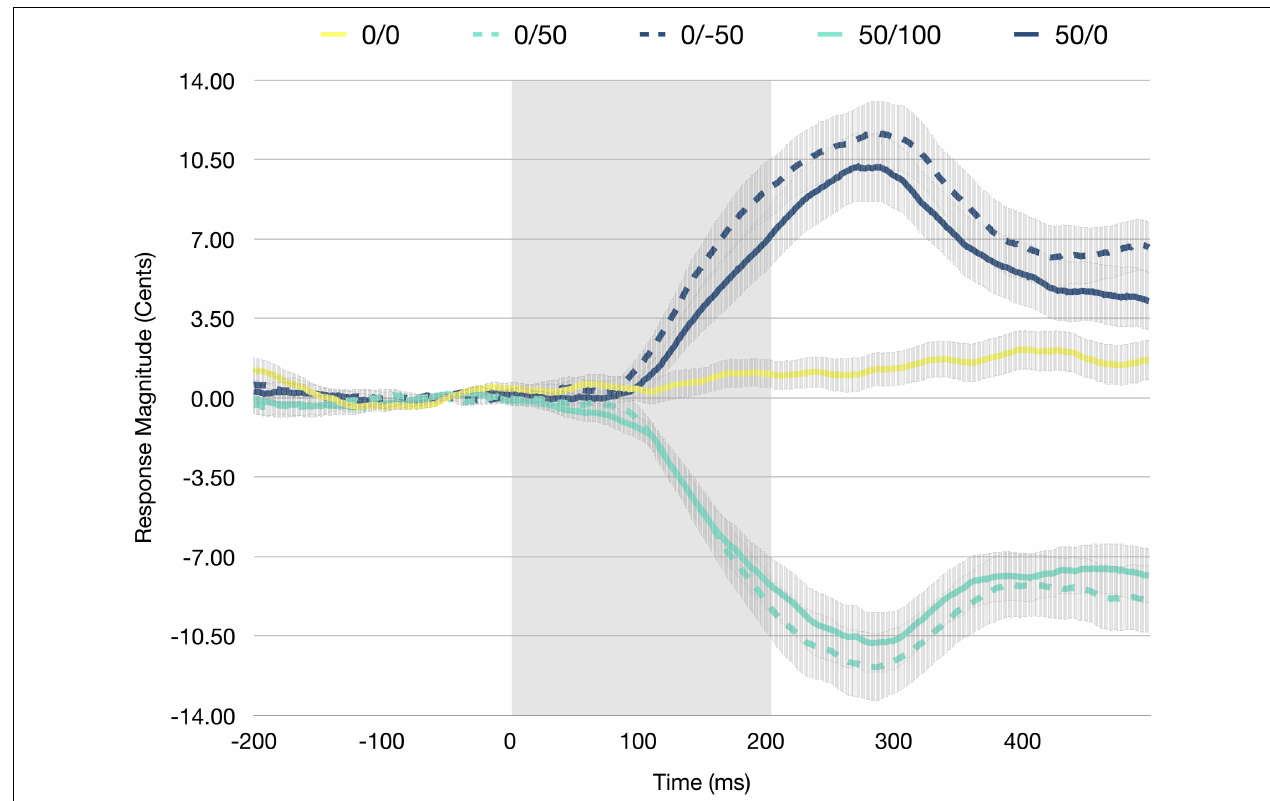
FIGURE 2 | Averaged F0 trace averaged across all participants for the unaltered (0/0), control up (0/50), control down (0/ − 50), experimental up (50/100), and experimental down (50/0) conditions. Error bars represent the standard error of the mean. The shaded portion (0–200 ms) indicates the perturbed portion of the